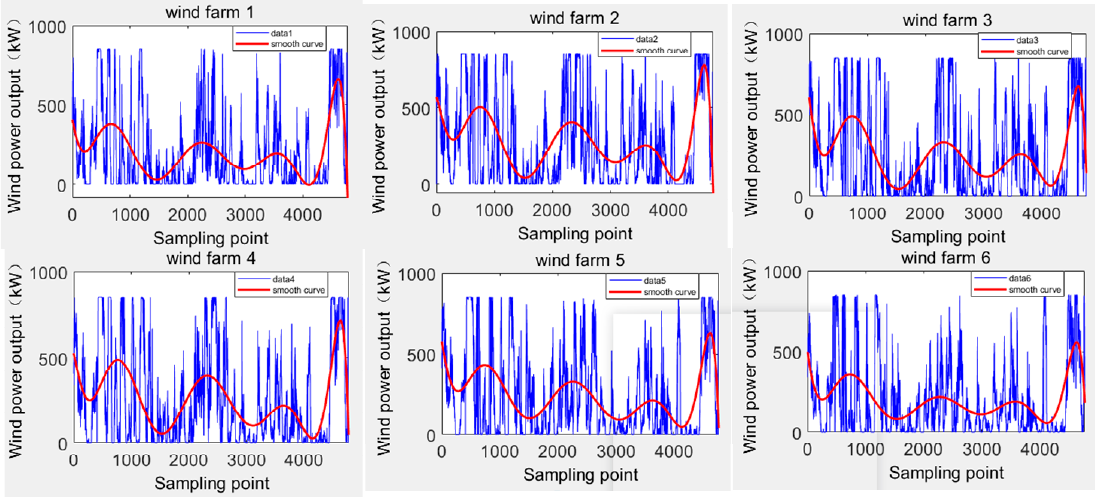
Figure 2. Historical data of six wind farms.